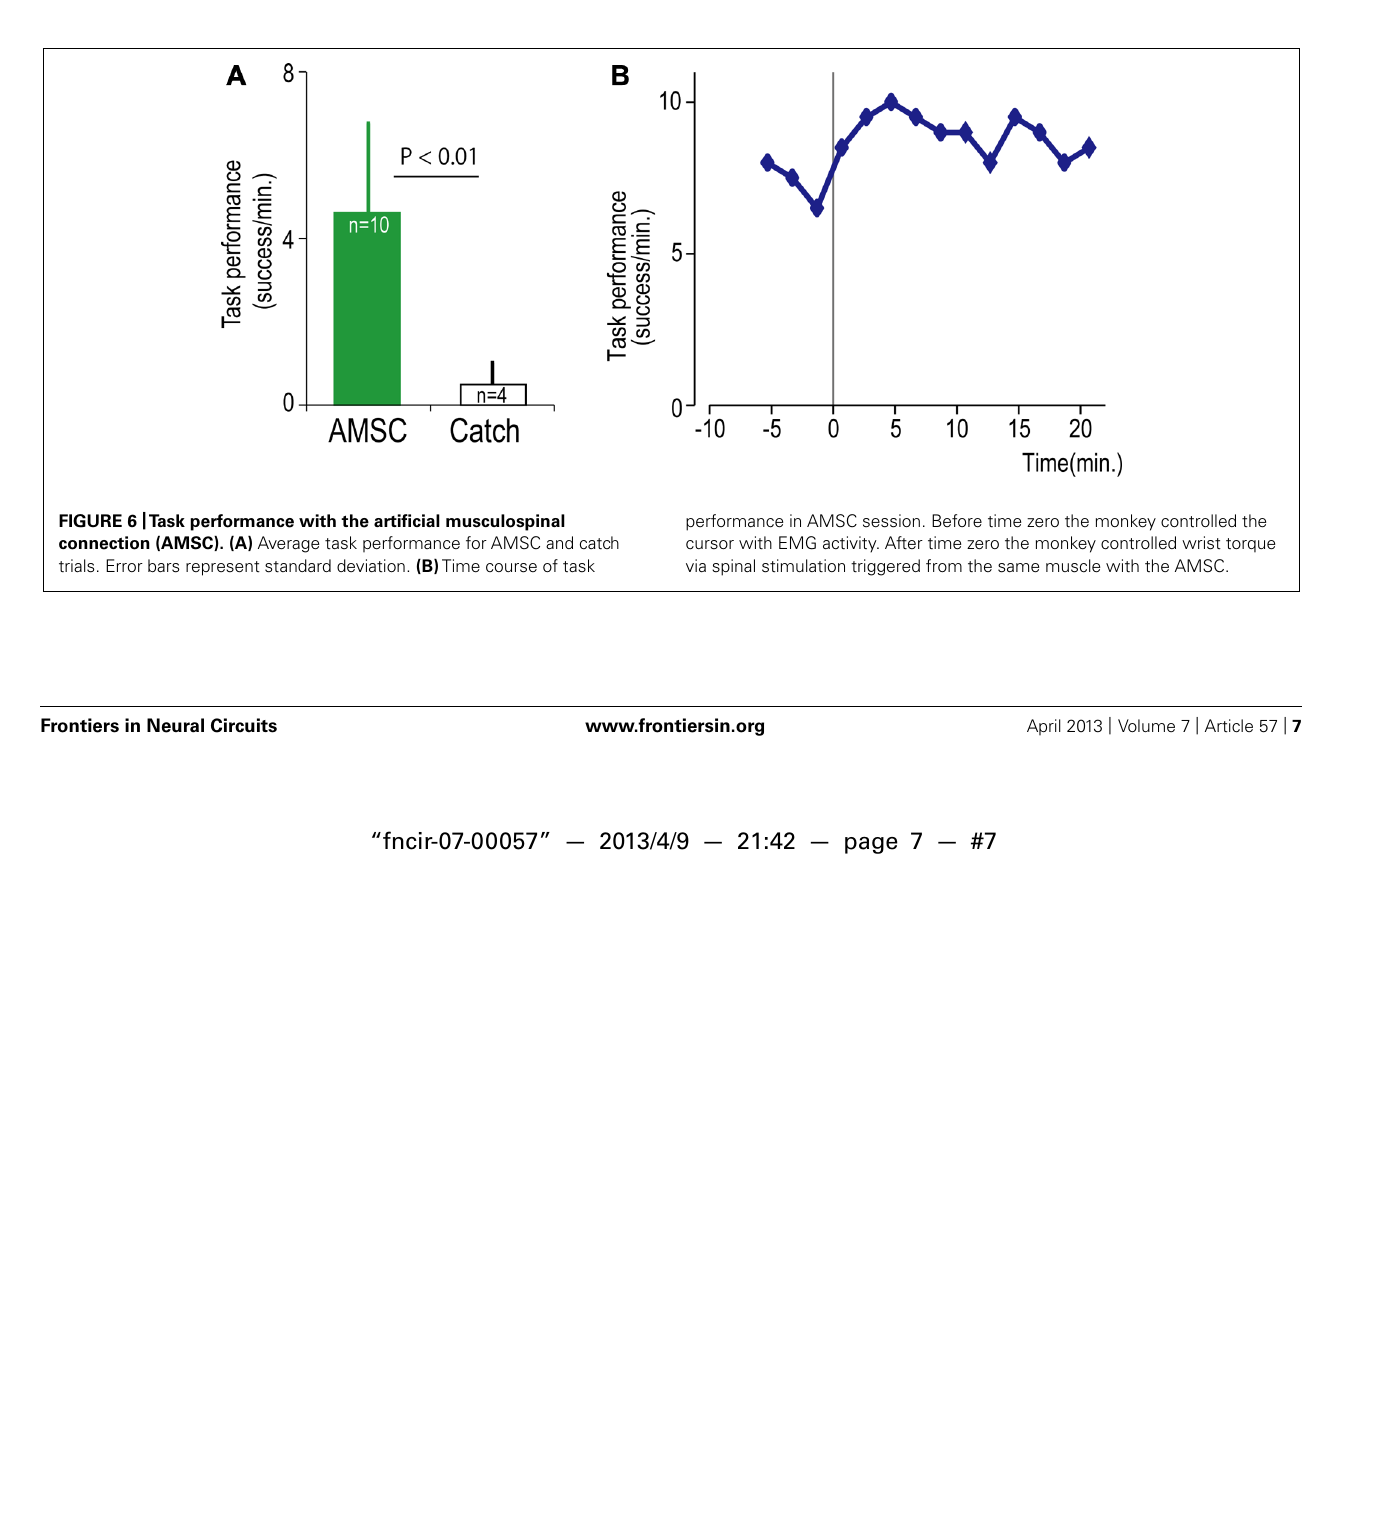
FIGURE 5 | Muscle-controlled spinal cord stimulation. (A) Schematic shows EMG activity gating a train of stimuli to a spinal site below the lesion. (B) Five successful trials with AMSC (green) and unsuccessful catch trials (white). During the catch trial, the monkey made several unsuccessful attempts to produce wrist torque, as seen in the EMG and torque.The blue rectangles indicate duration and force range of target.The pink bars indicate